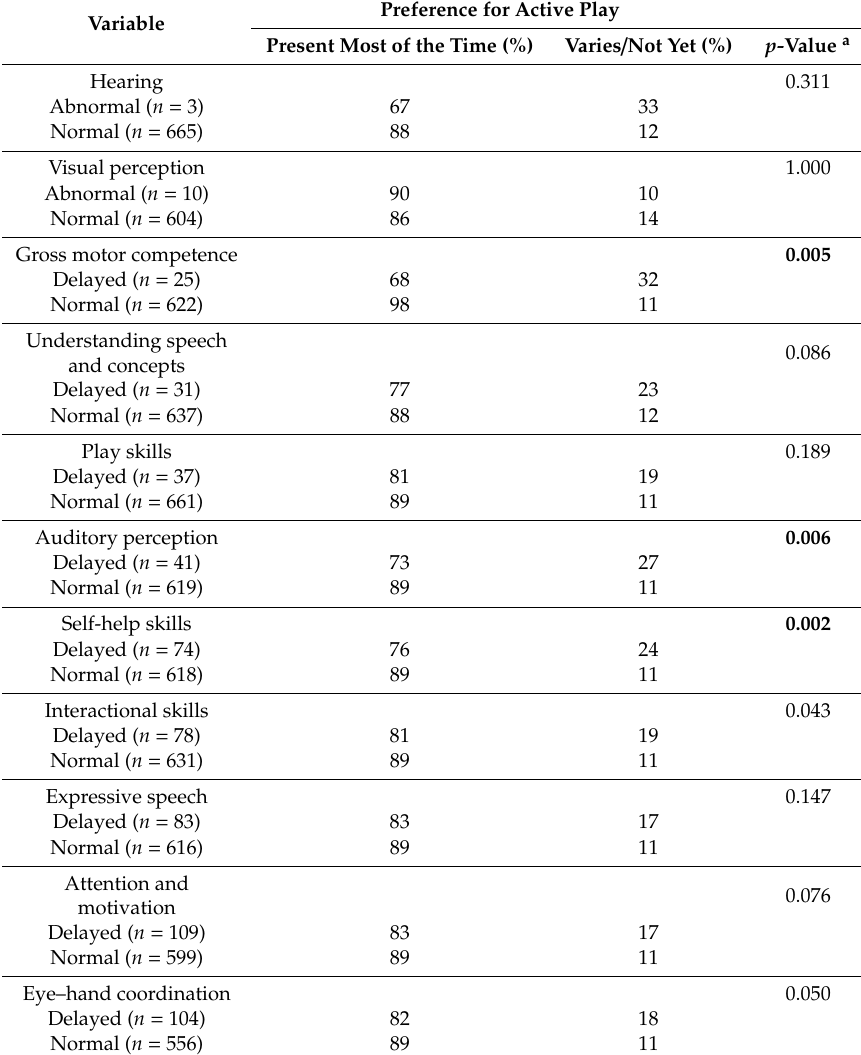
Table 2. The association of the neurological developmental variables with the preference for active play in 2.5-year-old children ( n = 717) in a